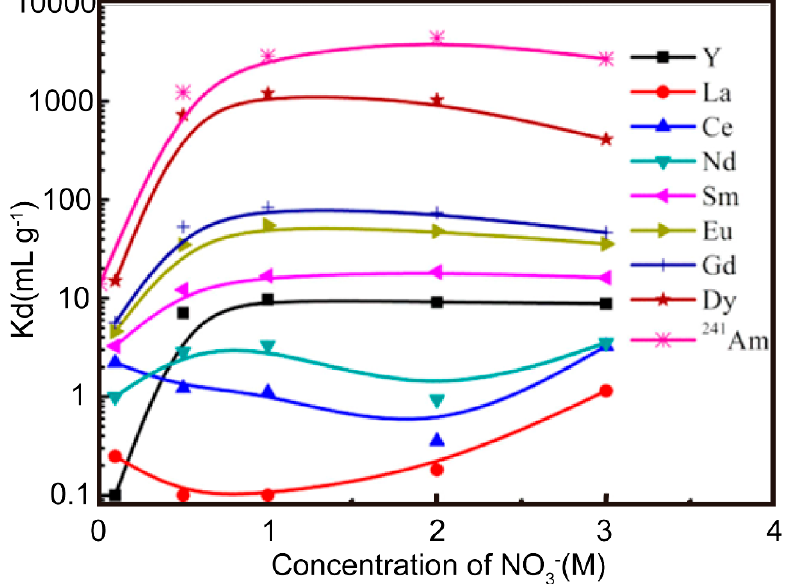
Figure 15. Effect of nitrate concentration on adsorption (0.01 M HNO 3 ; phase ratio = 0.1g/5 mL; 241 Am (III) = 1000 Bq mL − 1 ; Ln (II) = 1 mM; temperature = 298 K; contact time = 24 h; speed = 120 rpm) [59].